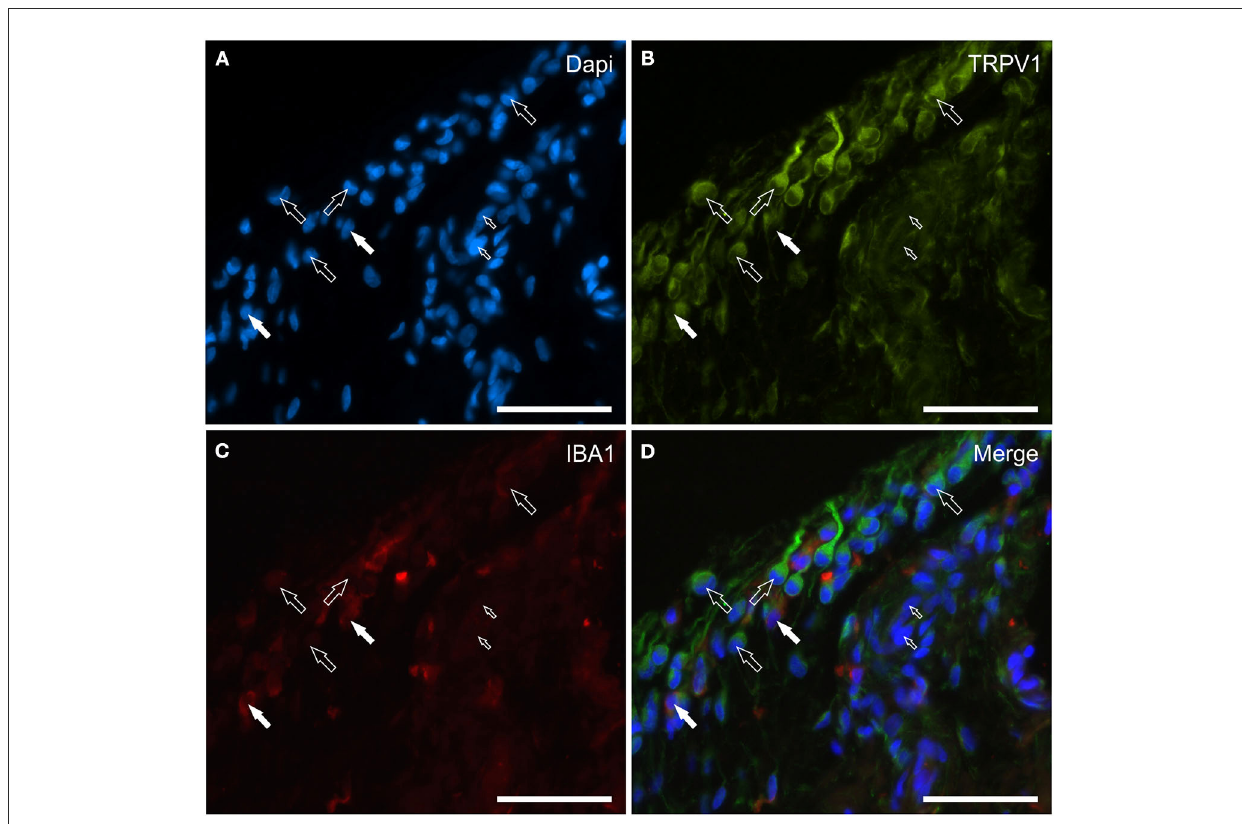
FIGURE5 Photomicrographs of the cryosections of the synovial membrane of a horse metacarpophalangeal joint showing transient receptor potential vanilloid 1 (TRPV1) (B) and IBA1 (C) immunoreactivity. Both of the two cell types lining the synovial intima, i.e., the fibroblast-like synoviocytes (FLS) and the macrophage-like synoviocytes (MLS), showed bright TRPV1 (Green) immunoreactivity. The TRPV1 immunolabeling was also evident in the elongated cellular process of the FLS extending through the joint cavity. The white arrows indicate the DAPI (Blue) labeled nuclei (A) of two IBA1 (Red) immunoreactive MLS co-expressing bright TRPV1 (B) and moderate IBA1 (C) immunoreactivity. The open arrows indicate some round or elongated FLS which were TRPV1 immunoreactive and IBA1 negative. The small open arrows indicate the DAPI labeled nuclei of the endothelial cells showing moderate TRPV1 immunoreactivity. (D) Merged image (Orange). Scale bar = 50 µ